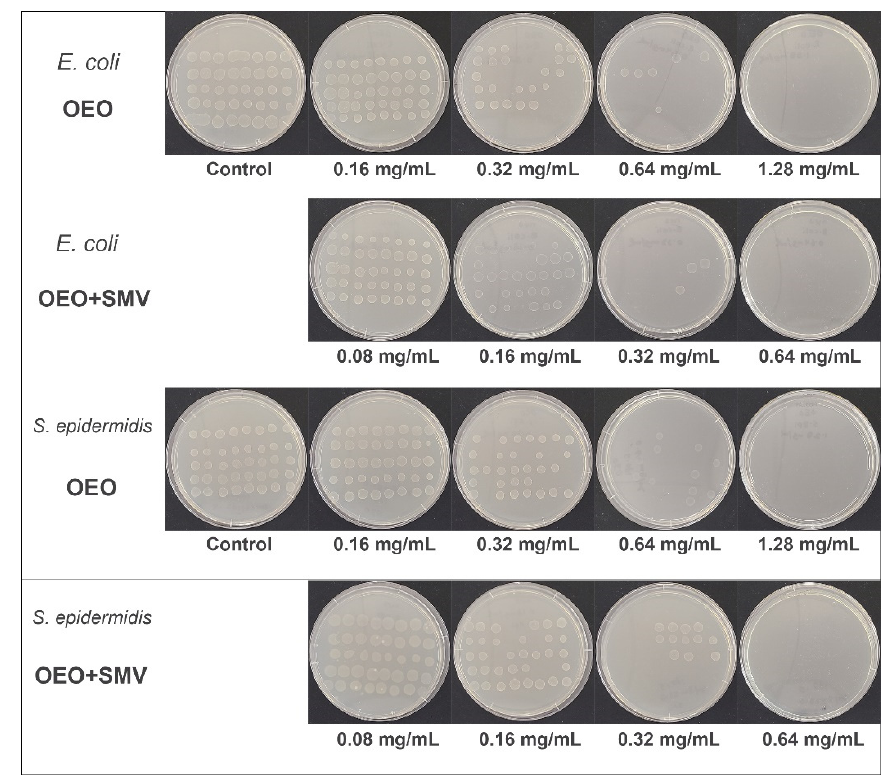
Figure 7. MIC tests of OEO and OEO-loaded SMV for E. coli and S. epidermidis .